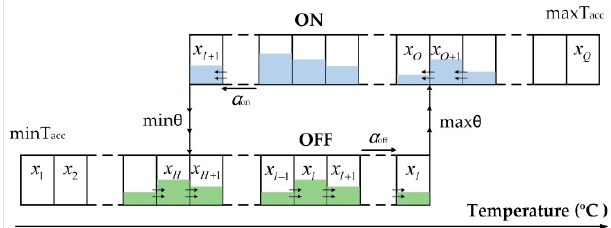
Figure 3. Finite-difference discretization of the system for state-space model derivation. Figure 3. Finite-di ff erence discretization of the system for state-space model